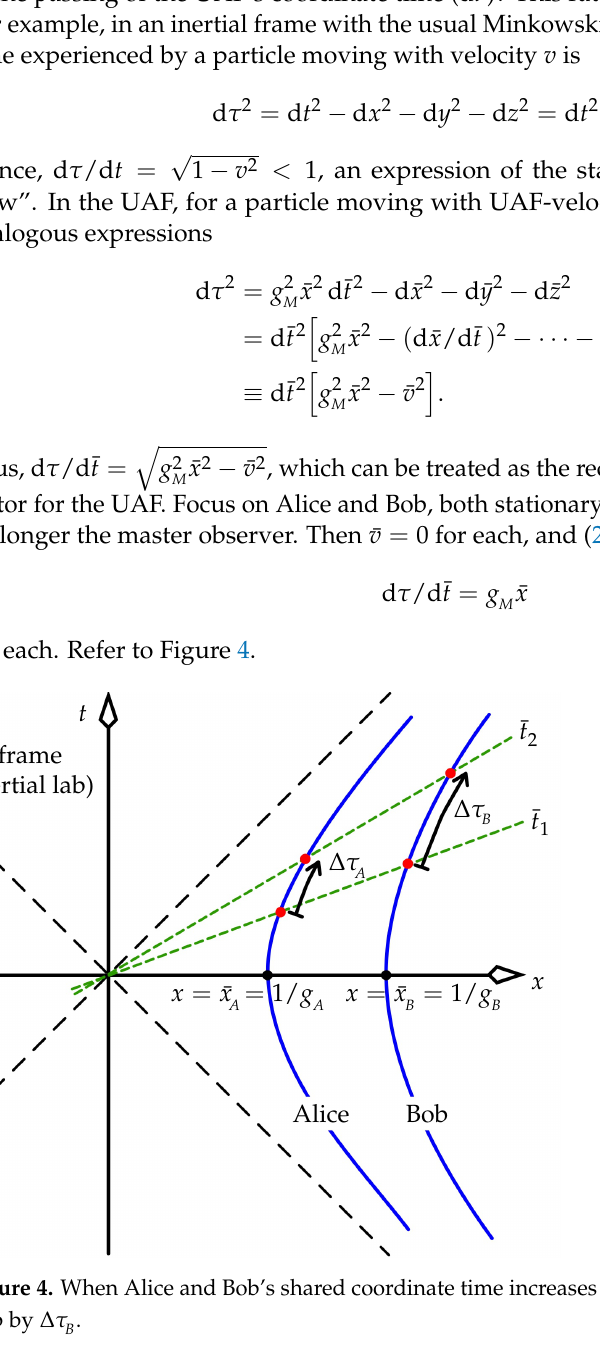
Figure 4. When Alice and Bob’s shared coordinate time increases from ¯ t Bob by ∆ τ B